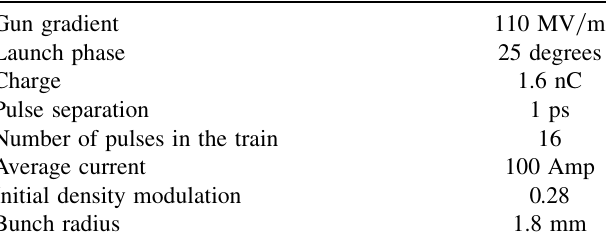
TABLE II. Electron source parameters.